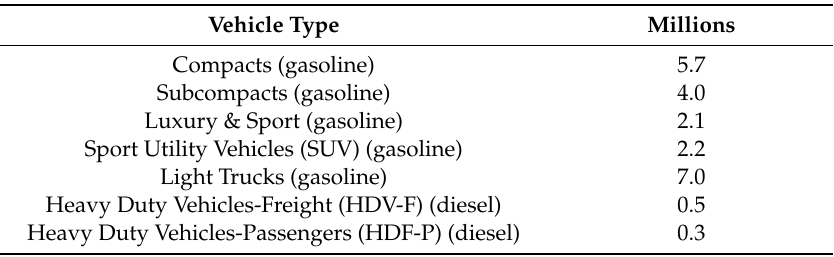
Table 3. Mexican vehicle fleet structure and fuel type in year 2010